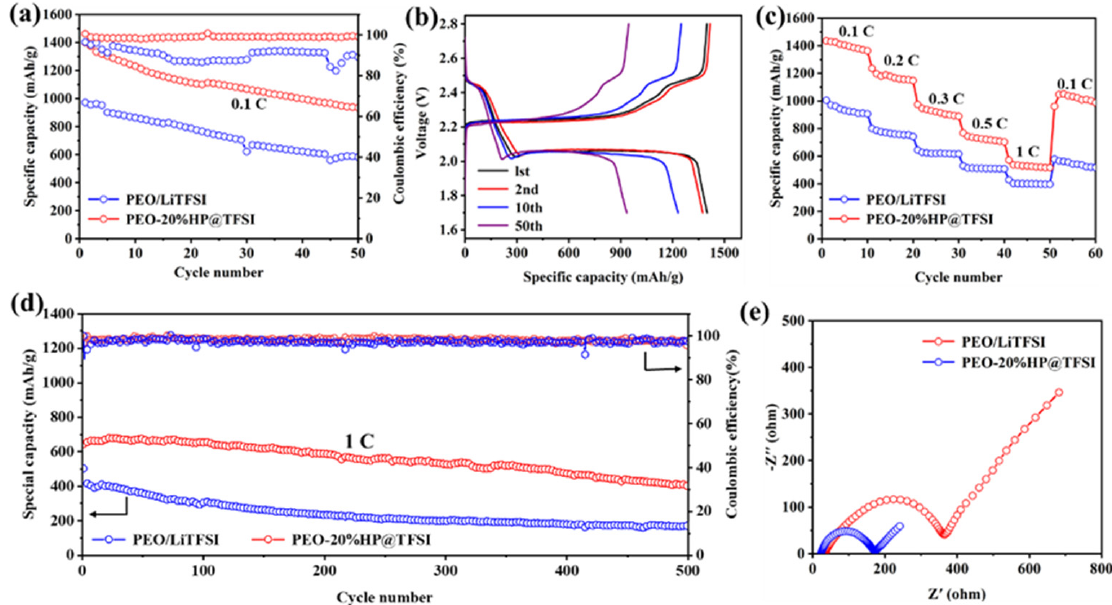
Figure 5. ( a ) cycle performance; ( b ) charge-discharge curves; ( c ) rate performance; ( d ) long-term cyclic stability of PEO-based battery at 1 C (60 ◦ C); ( e ) AC impedance spectra of lithium sulfur battery based on PEO/LiTFSI and PEO-20%HP@TFSI at 60 ◦ C.